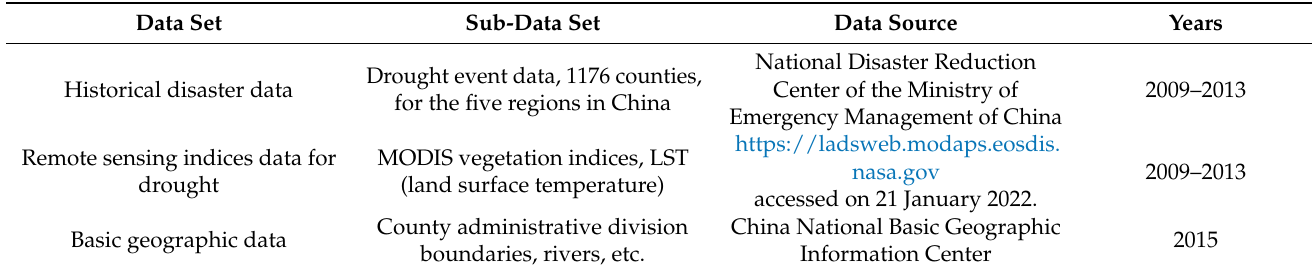
Table 1. Datasets used in this